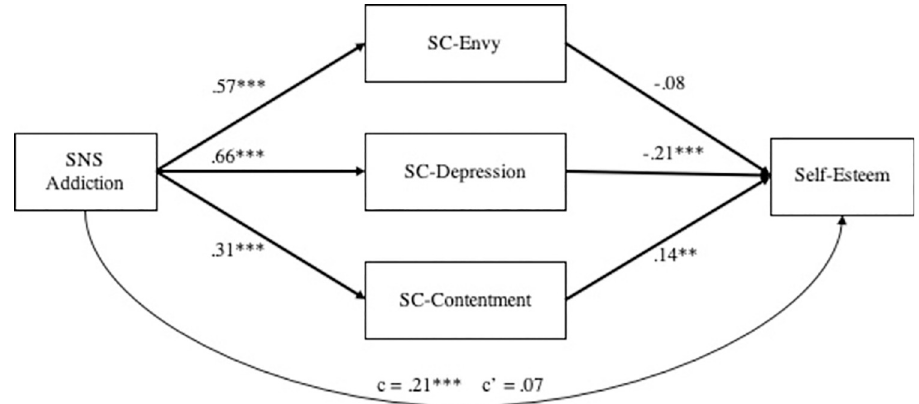
Fig 4. The jointly mediating role of SC-envy, SC-depression, and SC-contentment between SNS addiction and self-esteem.